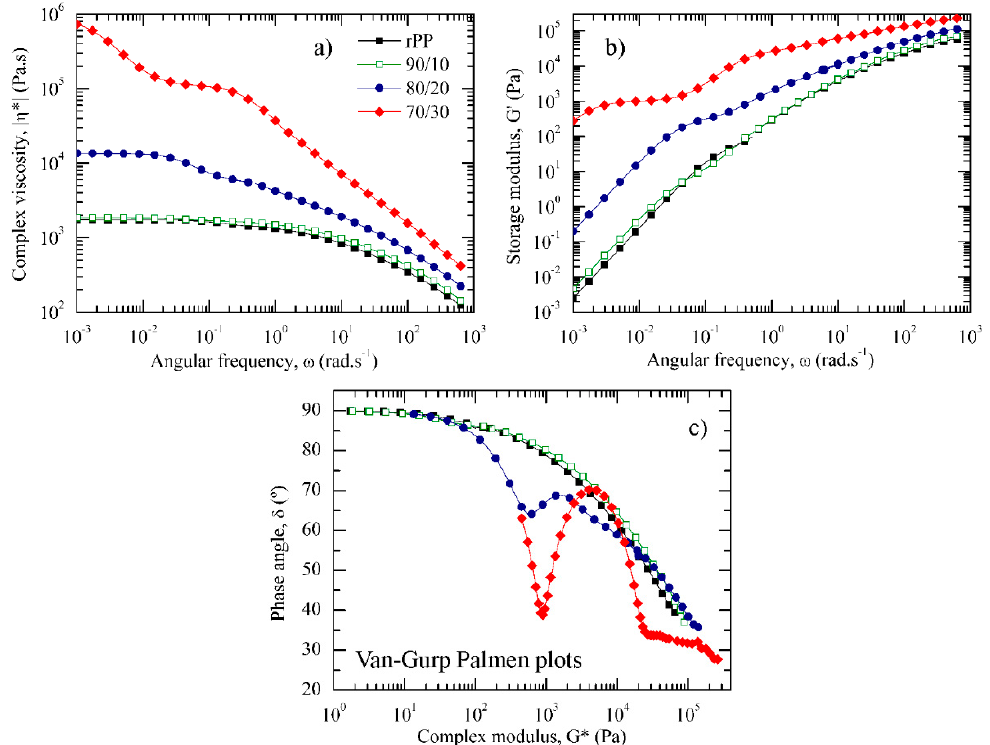
Figure 4. ω dependence at 190 °C of the ( a ) |η ∗ | and ( b ) G ′ . ( c ) Van Gurp–Palmen plots at 190 °C.